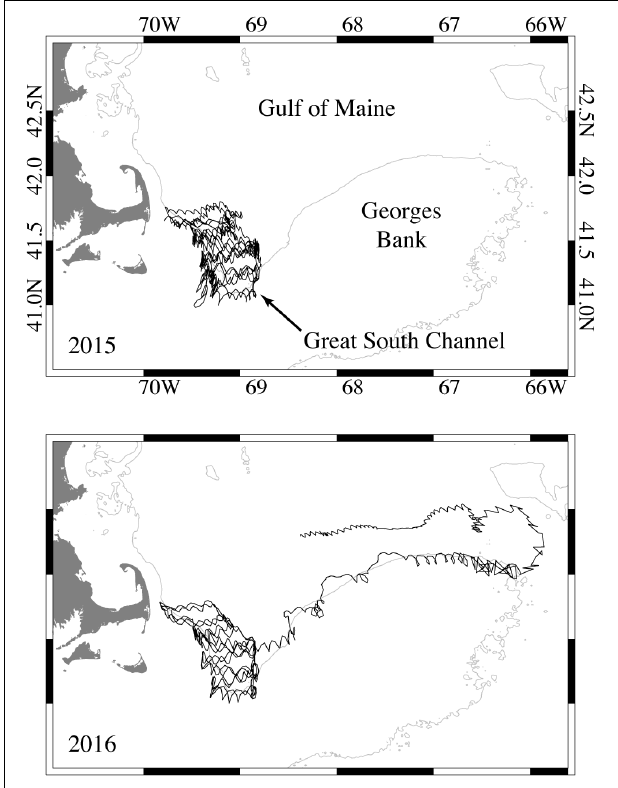
FIGURE 2 | Track of the WHOI Slocum glider in the southwestern Gulf of Maine off the coast of Cape Cod, Massachusetts during 2015 and 2016. The 50-fathom isobath is shown in